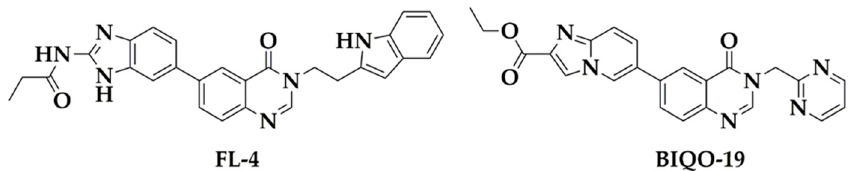
Figure 1. Chemical structures of FL-4 and BIQO-19.